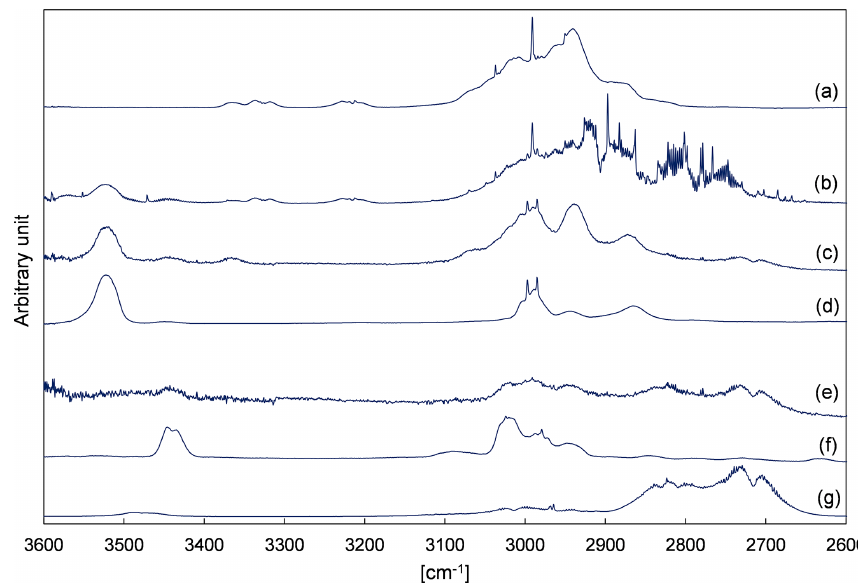
Figure 2. Exemplary FTIR spectra of a product study experiment of 3M3P2 + OH: (a) reaction mixture before irradiation; (b) reaction mixture at the end of the irradiation period; (c) residual spectrum after subtraction of methyl nitrite, methyl nitrate, HNO 3 , HONO, NO, NO 2 and HCHO from (b) ; (d) reference spectrum of 3-hydroxy-2-butanone (acetoin); (e) residual spectrum after subtraction of 3M3P2 and acetoin from (c) ; (f) reference spectrum of 2,3-butanedione (biacetyl); and (g) reference spectrum of acetaldehyde. The spectra are shifted and scaled individually for a better overview.